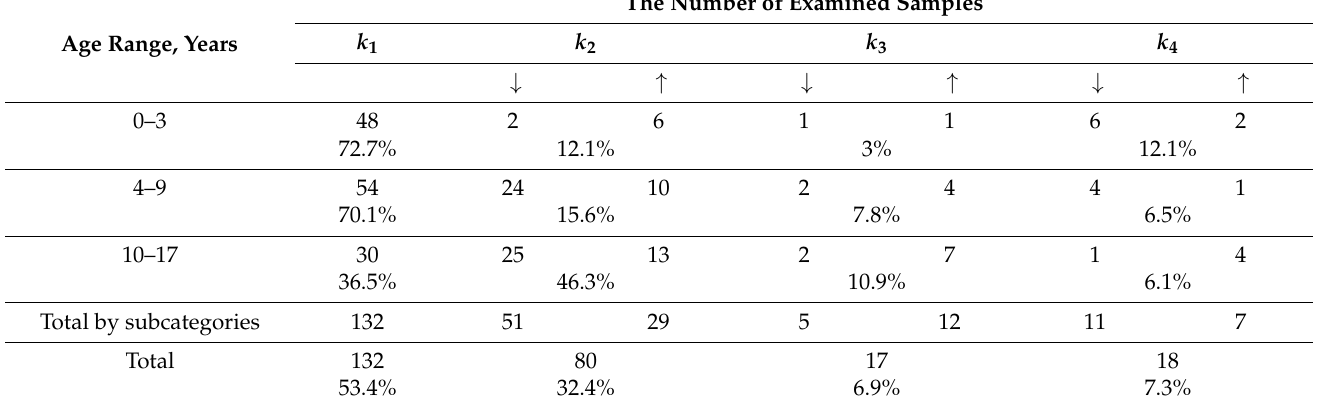
Table 2. Quantitative and percentage composition of patients by age category for immune system states k 1 , k 2 , k 3 , and k 4 (the symbol ↑ is used to indicate an excess of the reference interval (RI), the symbol ↓ is used to indicate a subsidence of the reference interval).